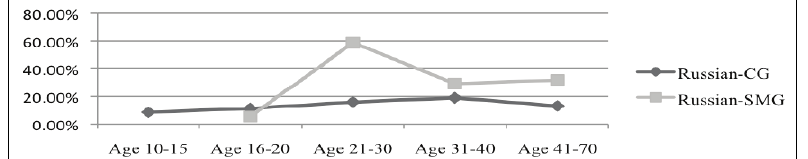
Figure 2: Age of the participants and non-target test